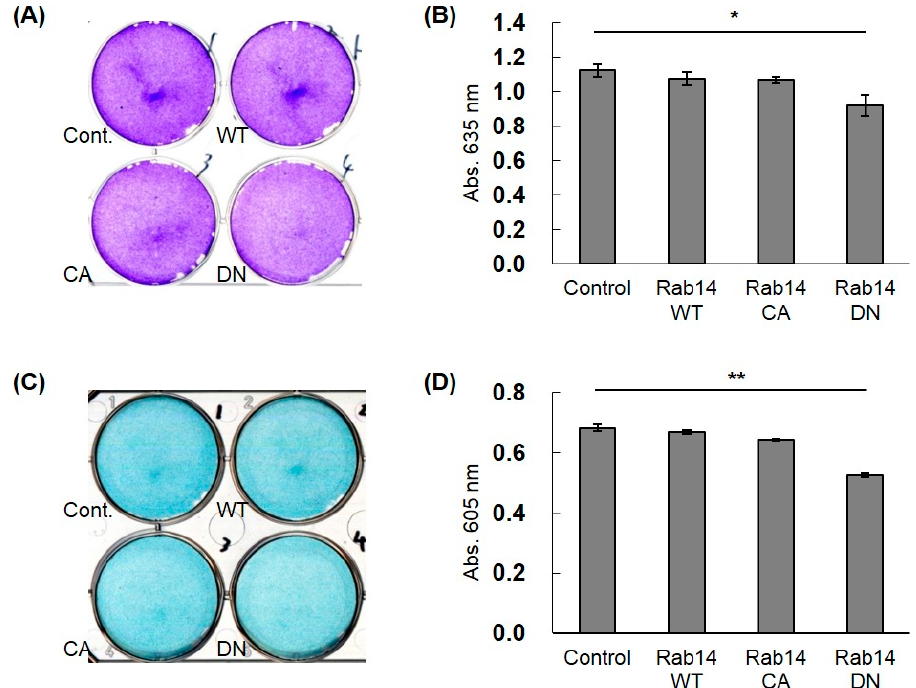
Figure 5. The effect of Rab14 on the accumulation of ECMs in HCS-2/8 cells. Halo (Cont.), Rab14WT, Rab14CA, and Rab14DN expression vectors and the control vector were transfected in the HCS-2/8 cells and cultured for 7 days, and then stained with toluidine blue ( A ) or alcian blue ( C ). The staining intensity was quantified by measuring the absorbance at 635 or 605 nm with a spectrophotometer ( B , D ). The data are presented as the mean ± SD of triplicate samples ( t -test * P < 0.05, ** P < 0.01).